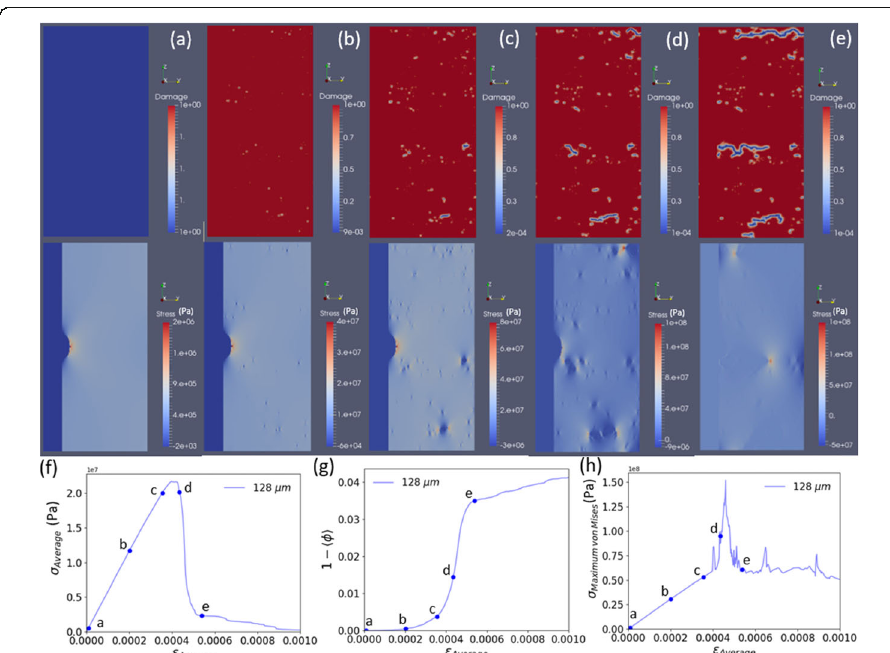
Fig. 5 Stress and damage progression in a disordered, notched, crystalline sample: Simulations of system size of L x = 8 μ m, L y = 0.5 mm, and L z = 1.0 mm where D = 2.995, W = 0.125 mm, and R G = 0.8 where ( a ) is the undamaged phase, ( b ) is the early damage phase, ( c ) is the late damage accumulation phase, ( d ) is the multiple crack nucleation event, and ( e ) is the crack propagation where the damage and stress distributions and are displayed (top, middle), respectively, and ( f ), ( g ), and ( h ) are the average stress (Pa) vs. strain, average damage vs. strain, maximum von Mises stress (Pa) vs. strain (bottom) respectively, where the five locations are identified on the